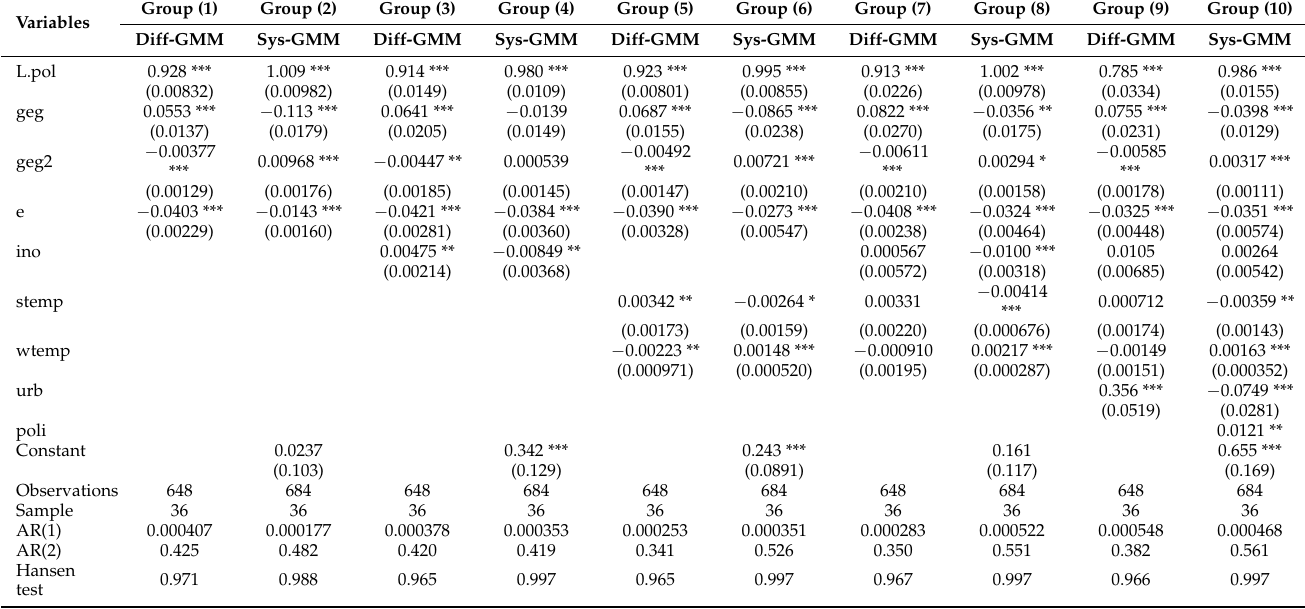
Table 9. The pollution function